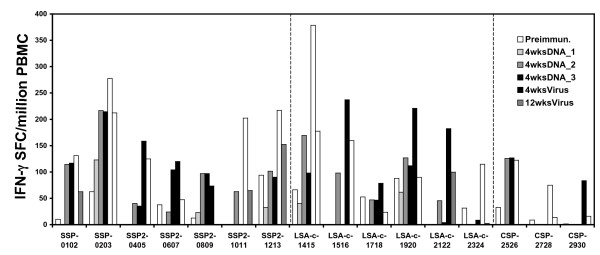
IFN-γ responses to individual peptide pools derived from PfCSP, PfSSP2/TRAP or PfLSA1. PBMC from monkey RBsG (CSLAM/PBS) collected at time points as defined in the legend to Figure 2 were assayed against pools of synthetic peptides spanning the complete sequences of PfCSP, PfSSP2/TRAP or PfLSA1 by IFN-γ ELIspot.